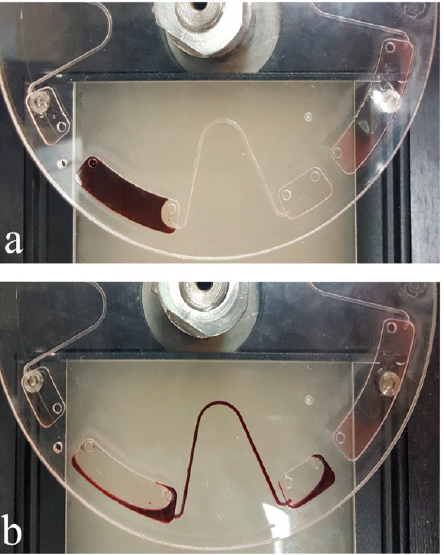
Figure 1. The top view of a centrifugal microfluidic disc; ( a ) the liquid is pipetted into the